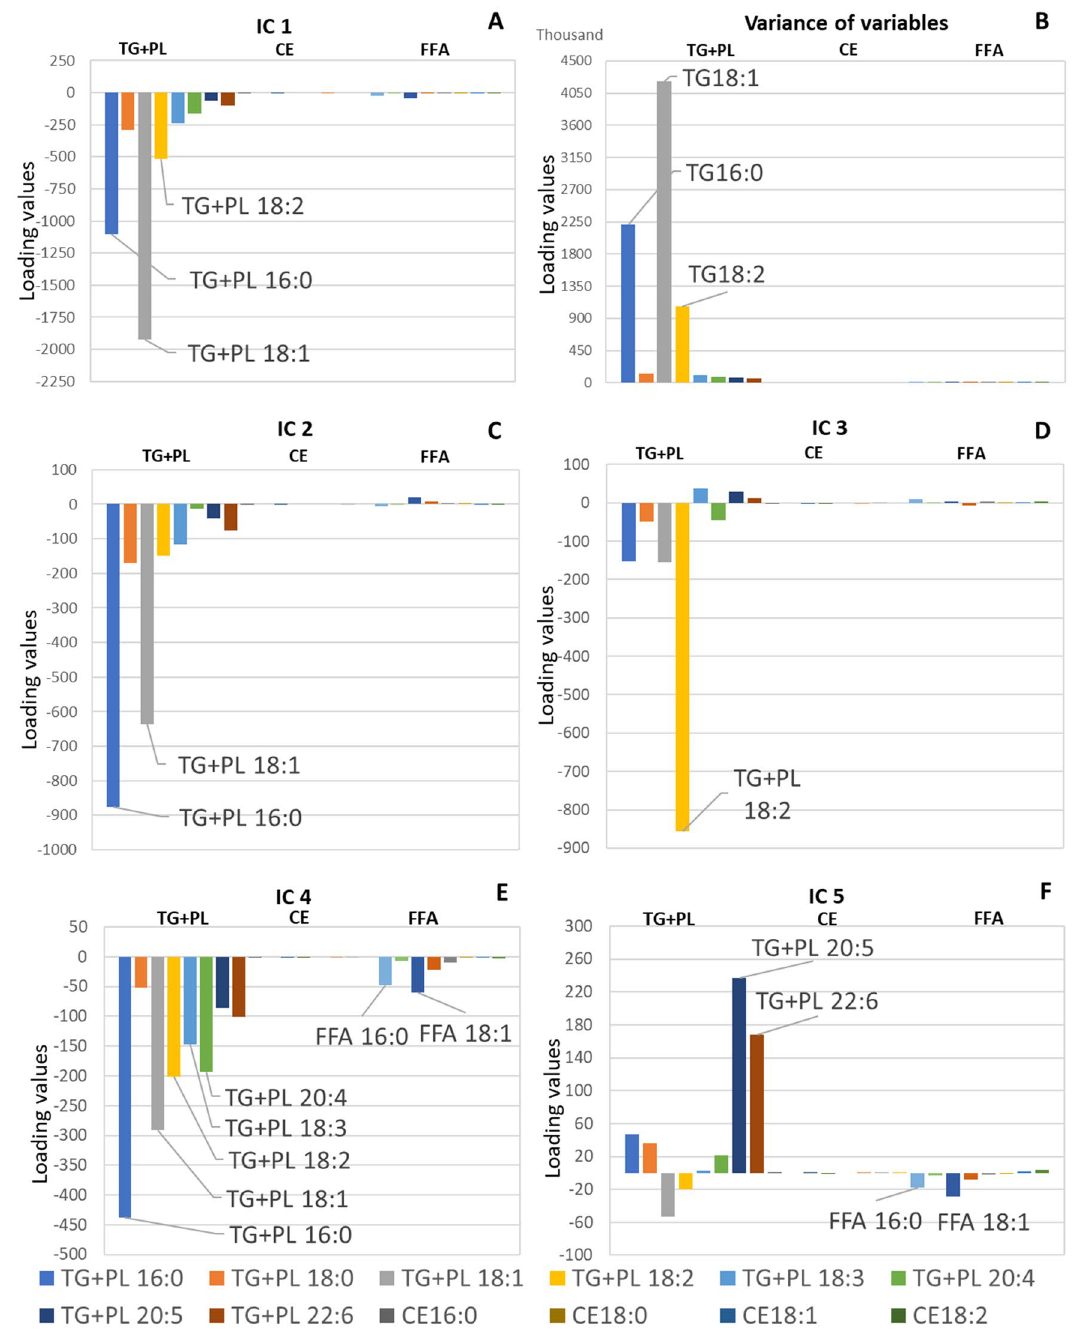
Figure 1. Histograms of independent component analysis results, including ( A ) IC 1, ( B ) variance of variables, ( C ) IC 2, ( D ) IC 3, ( E ) IC 4, and ( F ) IC 5. The omega groups of FAs were